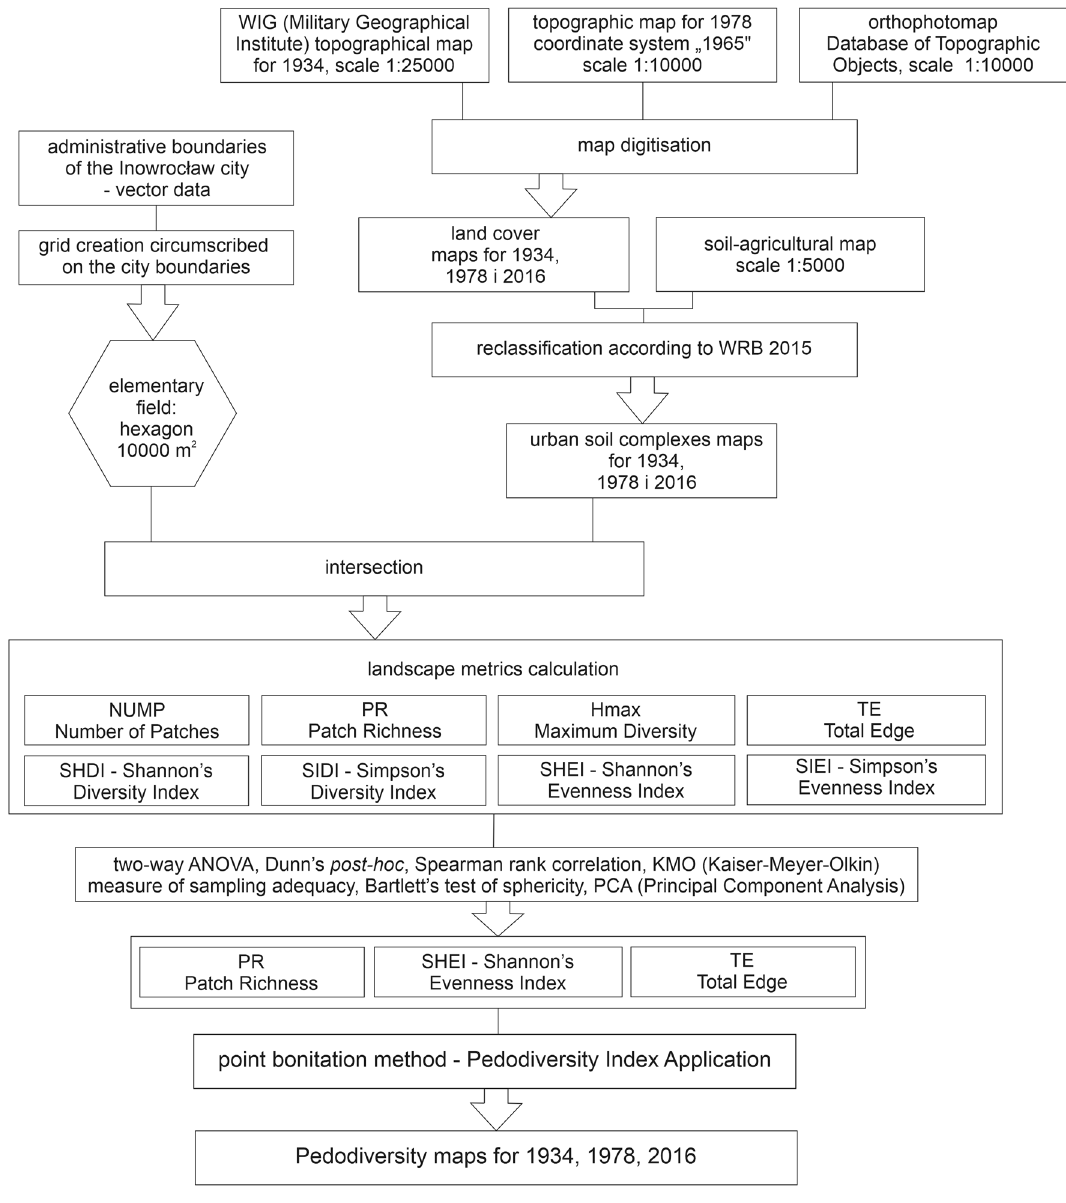
Figure 2. A flow chart of research